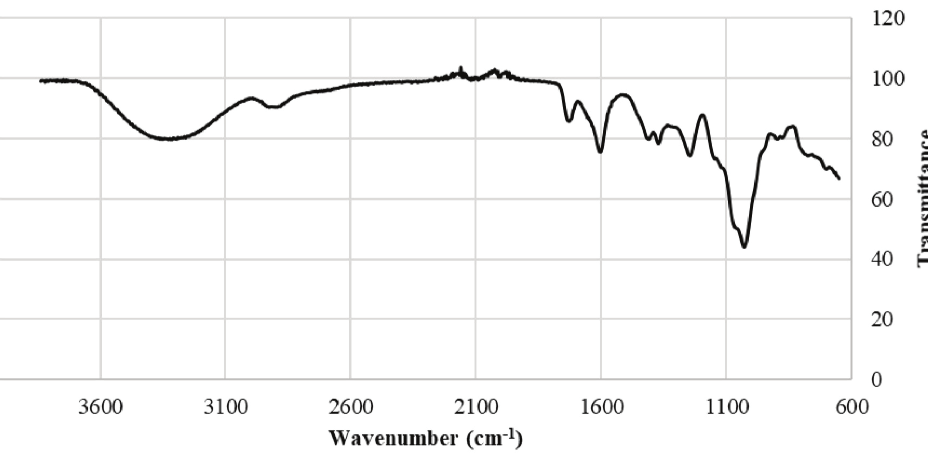
Fig. 3 – FTIR spectra of precipitated EPS from repeated fed-batch cultivation